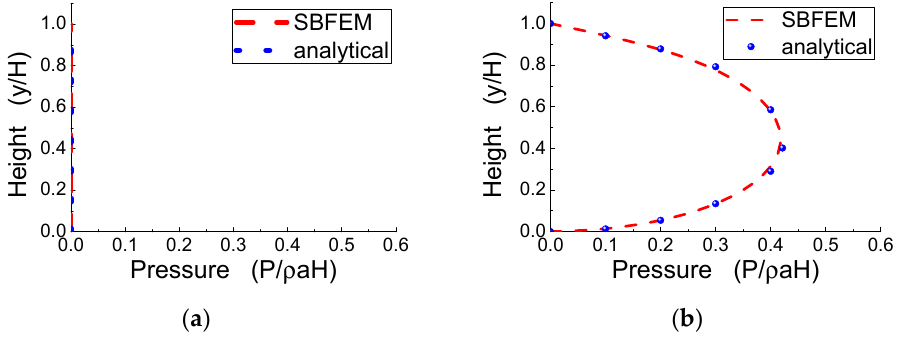
Figure 18. Semicircular valley with transverse excitation: ( a ) along line AB and ( b ) along line BC.